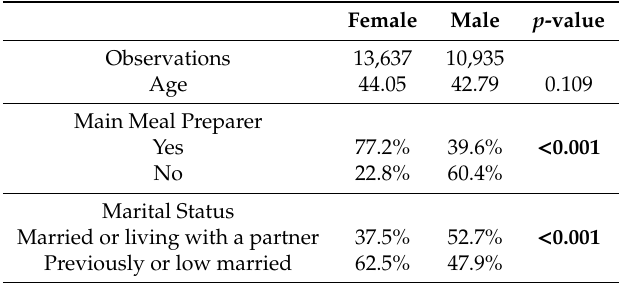
Weighted percentages are presented. Bolded numbers indicate p <